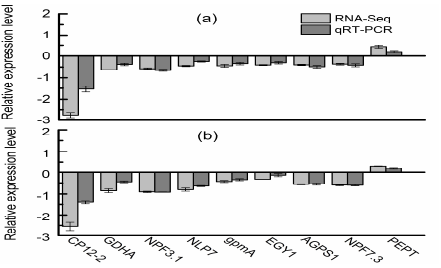
Figure 3. RNA-seq results confirmed by quantitative qRT-PCR. ( a ) qRT-PCR validation for nine selected genes in flue-cures tobacco and burley tobacco at same nitrogen level; ( b ) qRT-PCR validation for nine selected genes in flue-cures tobacco and burley tobacco at same leaf biomass condition. Error bars represent standard error ( n = 6).